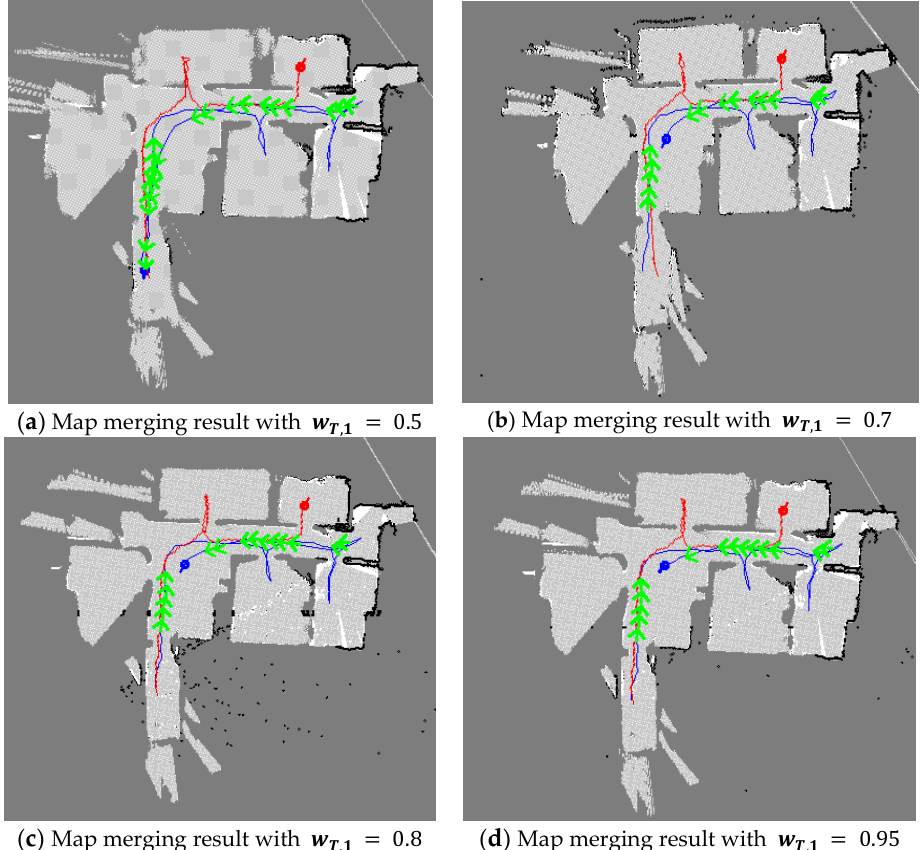
Figure 16. Map merging result with the TSD grid update (when there are errors in map-matching, it is beneficial to update the merged map with a larger weight w T , 1